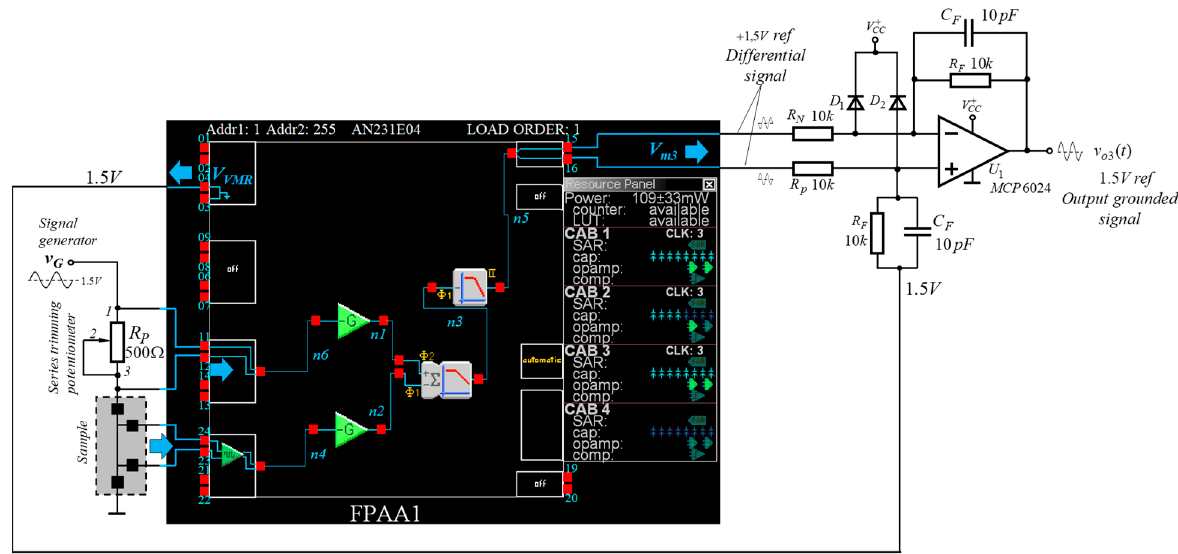
Figure 3. FPAA-based programmable circuit diagram used for thermal conductivity measurement, applying the 3 ω method. applying the 3 ω